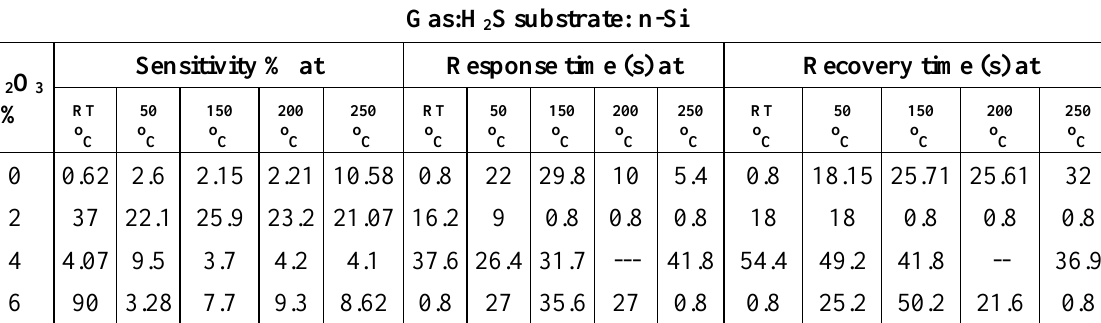
O as a function of operating temperature upon exposure H 2 3 Gas:H S substrate: n-Si 2